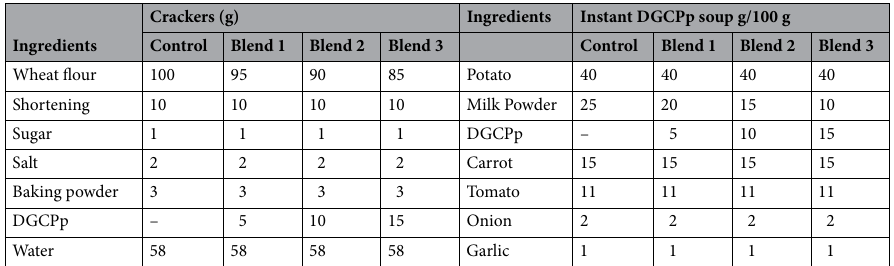
Table 8. Recipe formulation of crackers and instant DGCPp